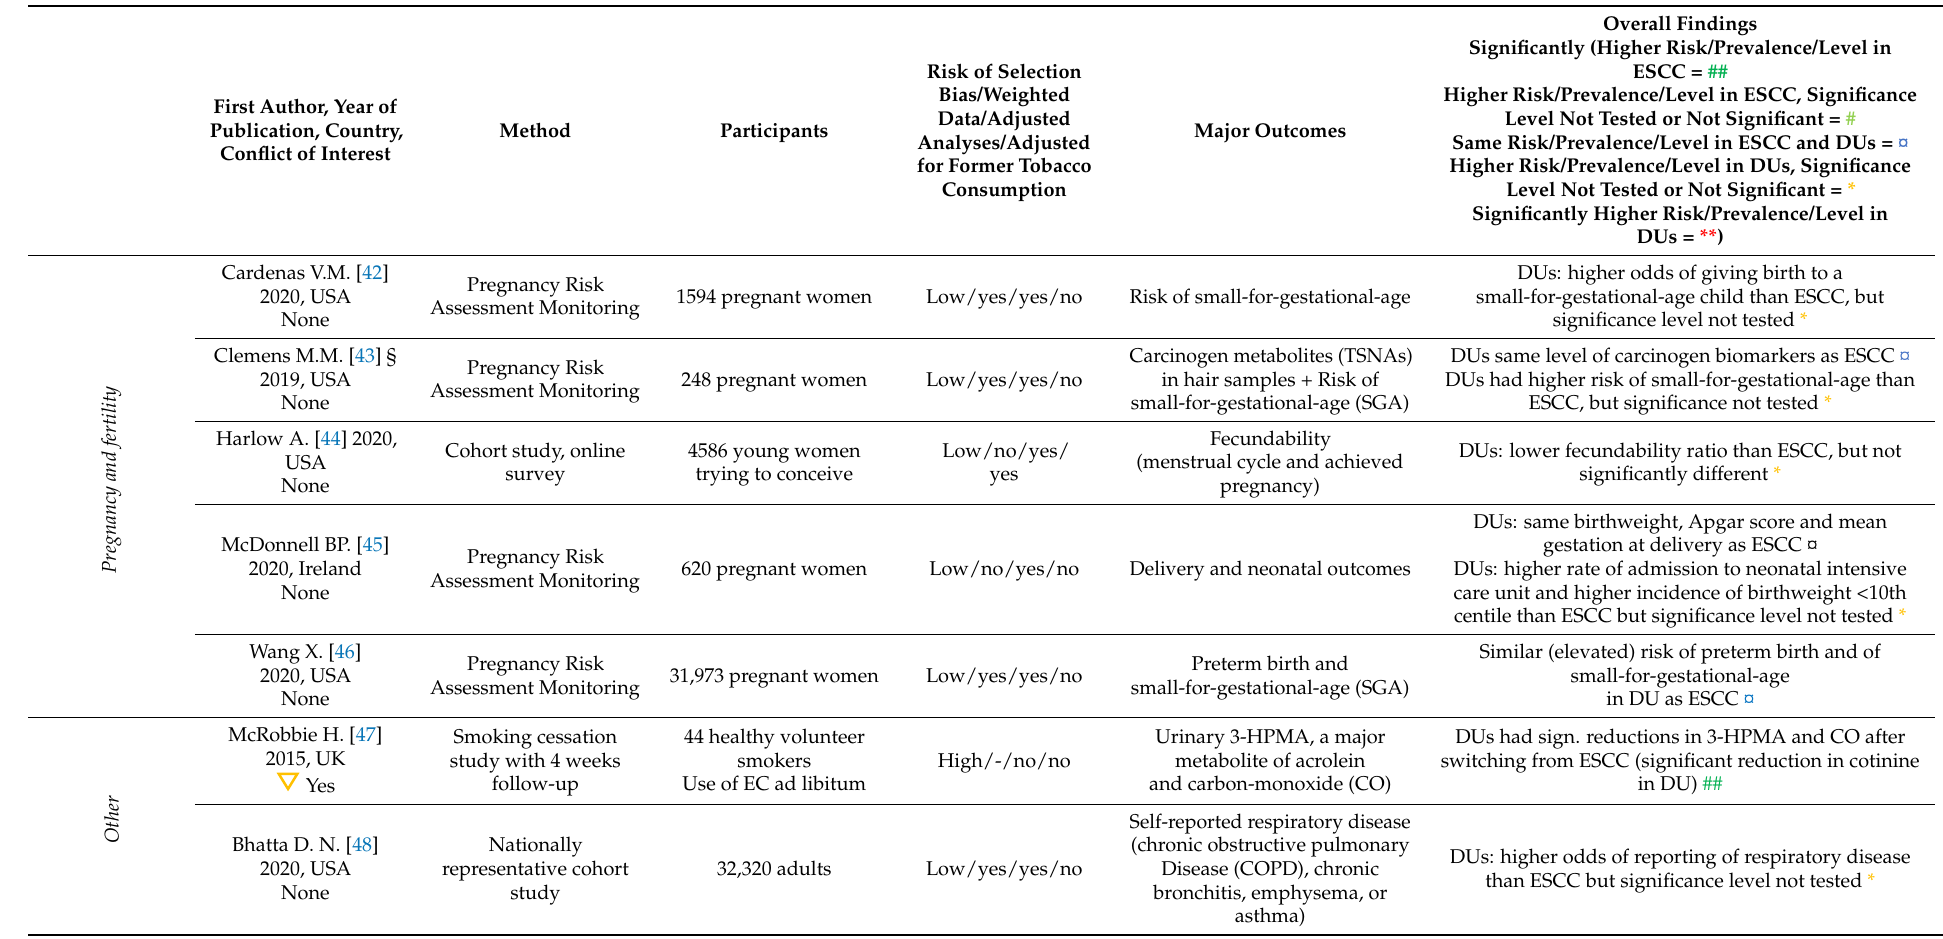
Table 1. Prospective studies investigating the potential harm in DUs compared to ESCC.